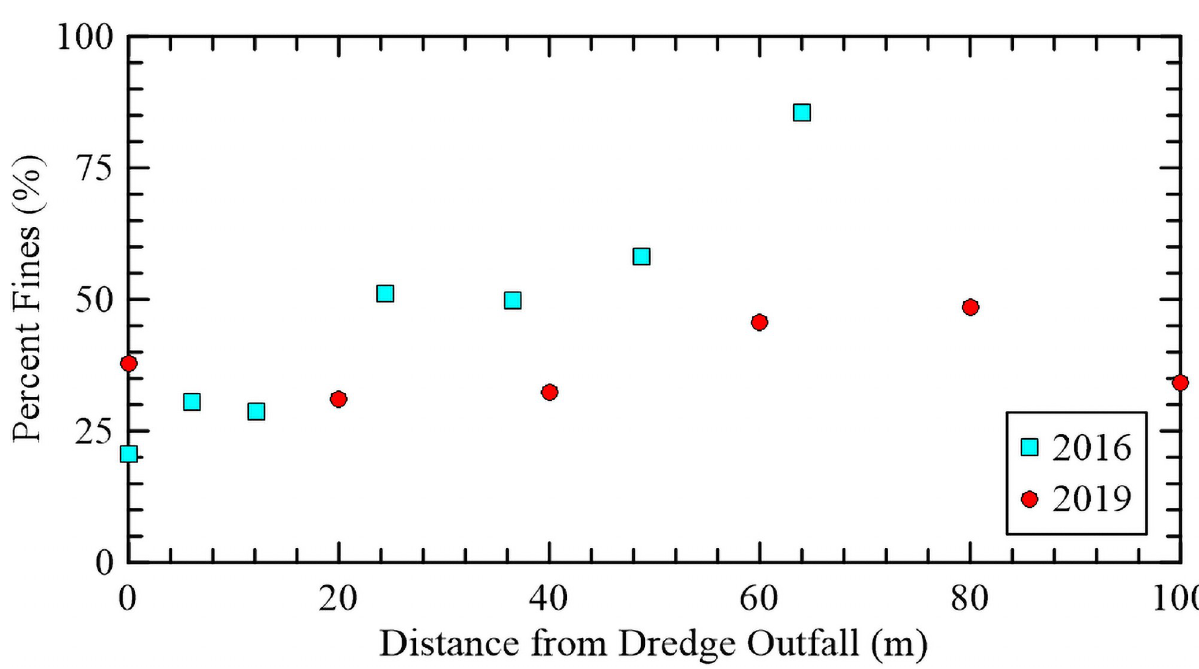
Fig 5. Percent of fine grained material ( < 0.075 mm) with distance from the dredge outfall from field investigations.